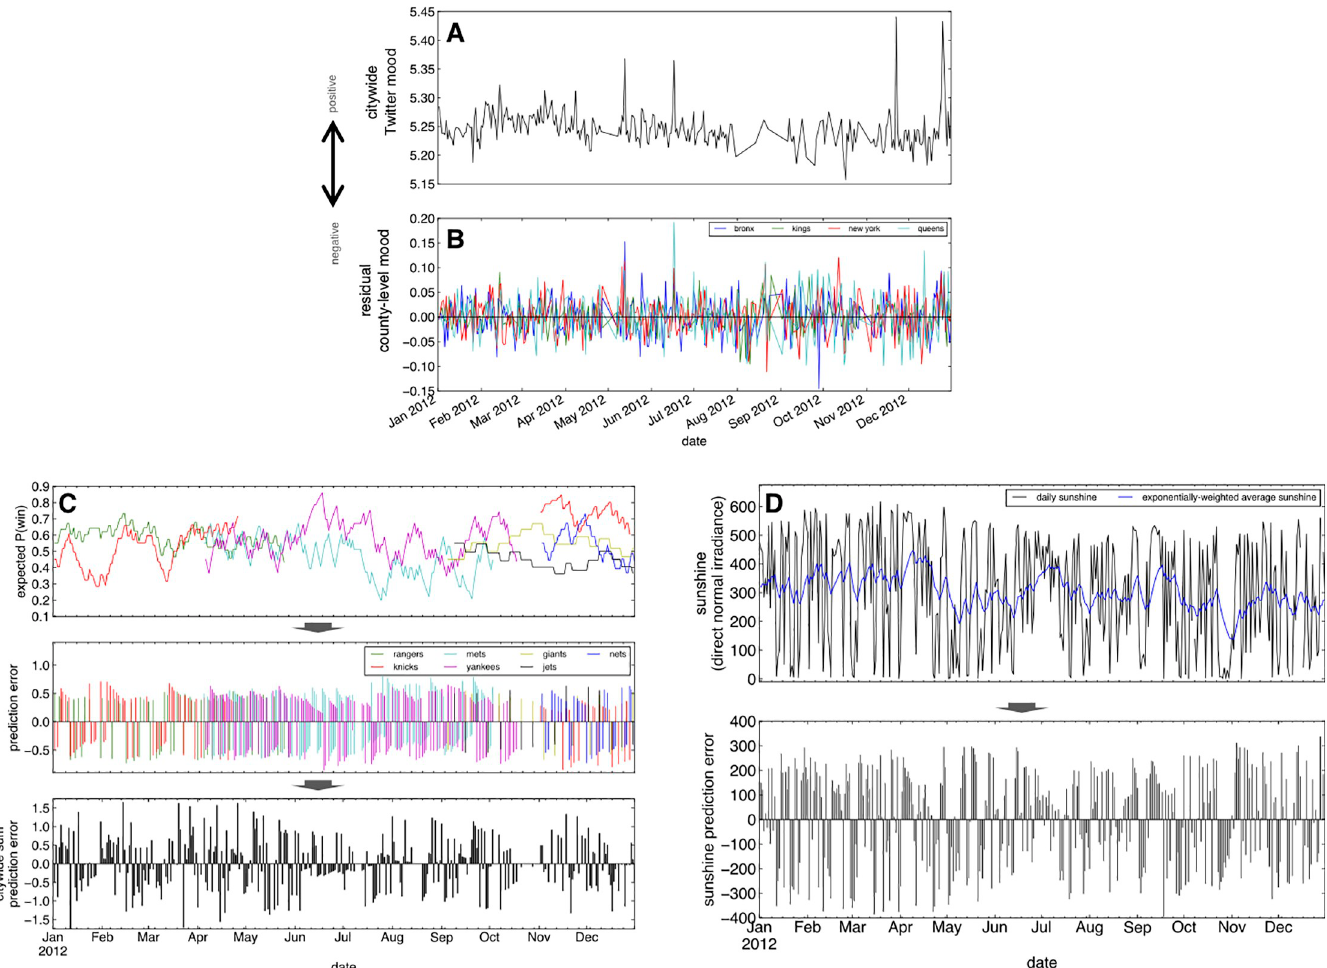
Fig 1. Timecourse of Twitter-inferred mood. (A) The timecourse of Twitter-inferred mood of NYC residents exhibits marked day-to-day variability. (B) Controlling for a number of nuisance variables, fluctuations in mood appear to be prominent and correlate across counties (i.e., boroughs) within NYC. (C) Exponentially-weighted estimates of winning probabilities of each NYC-based sports team based on recent outcome history (top panel). Each time a team plays, a prediction error is computed as the deviation between the outcome (win versus loss) and the expected probability of winning (middle panel). The citywide sports prediction error (bottom panel) was computed by summing each team’s prediction error for each day, reflecting a citywide deviation from expectation amongst teams that played each day. (D) From day- to-day satellite-derived sunshine levels (black line, top panel) in NYC, we calculated an exponentially-weighted expectation of sunshine level (blue line) and in turn, computed a daily sunshine prediction error based on the deviation between current and expected sunshine levels (bottom panel). All data plotted in this figure are from the exploratory dataset (the year